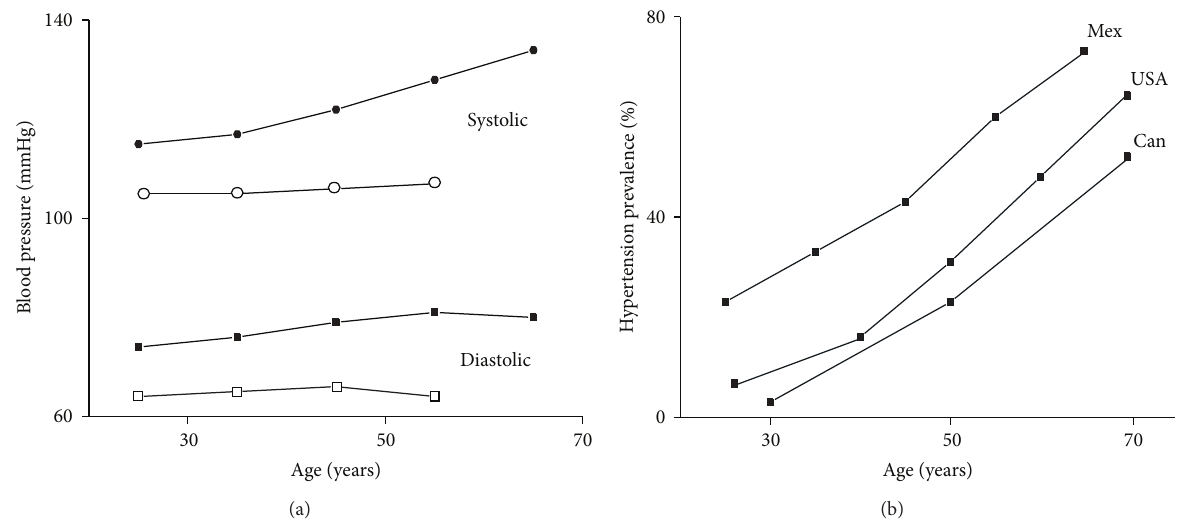
Figure2:Bloodpressureandhypertensionduringtheadulthood.(a)Systolicanddiastolicbloodpressuremeanvalues(representedin10-year age group intervals) as a function of age in nonacculturated populations (which do not add salt to food, open symbols) and in an acculturated (the Mexican) population (which does add salt to food, closed symbols). Data adapted from [3, 16]. (b) Hypertension prevalence as a function of age in the populations from Mexico (Mex), the United States of America (USA, both represented in 10-year age group intervals, with the exception of the first point of the USA graph, which represents a 17-year group interval), and Canada (Can, represented in 20-year age group intervals). Data adapted from [3, 17,